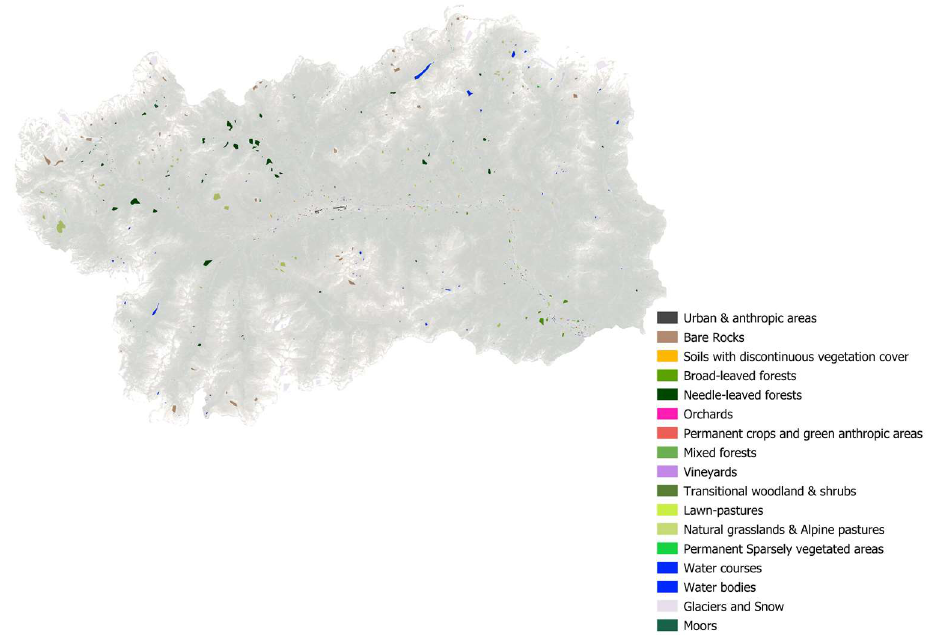
Figure 4. An overlook of ROIs distribution for both training and validation sets. Most of ROIs